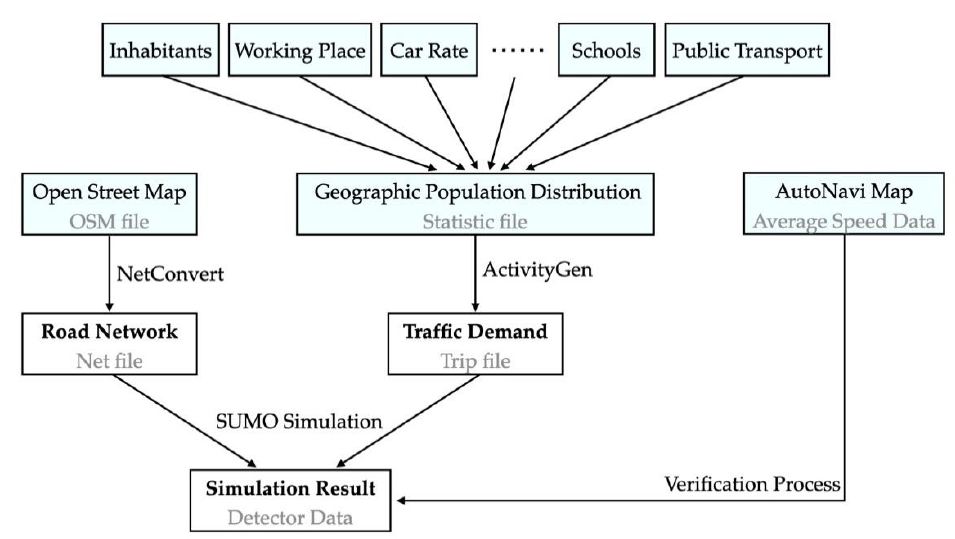
Figure 3. Flow chart of the process of building the simulation. (The data in blue boxes are obtained online).